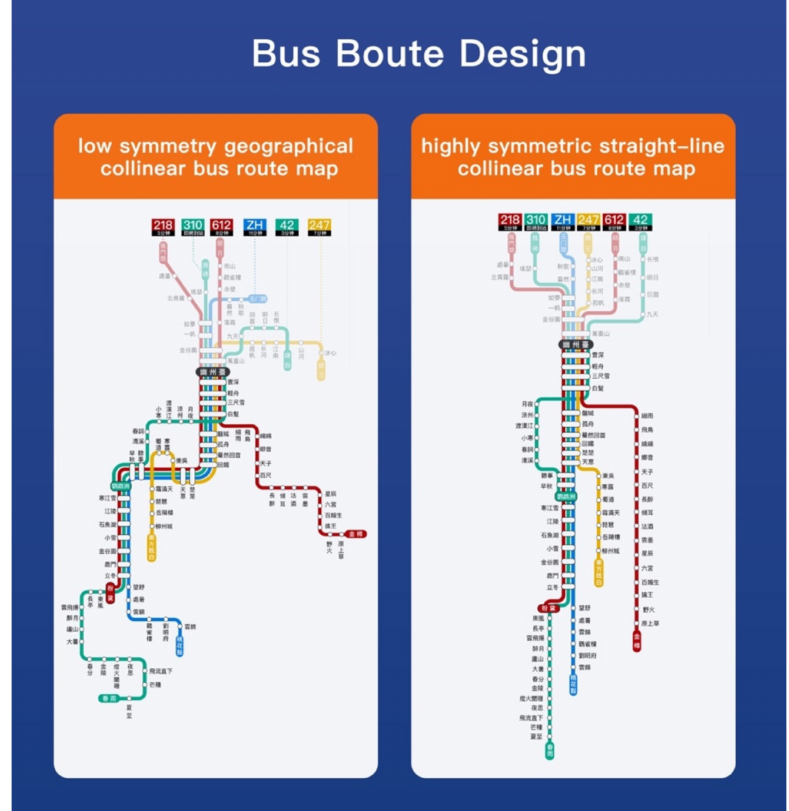
Figure 2. Presentation methods of the bus route map.